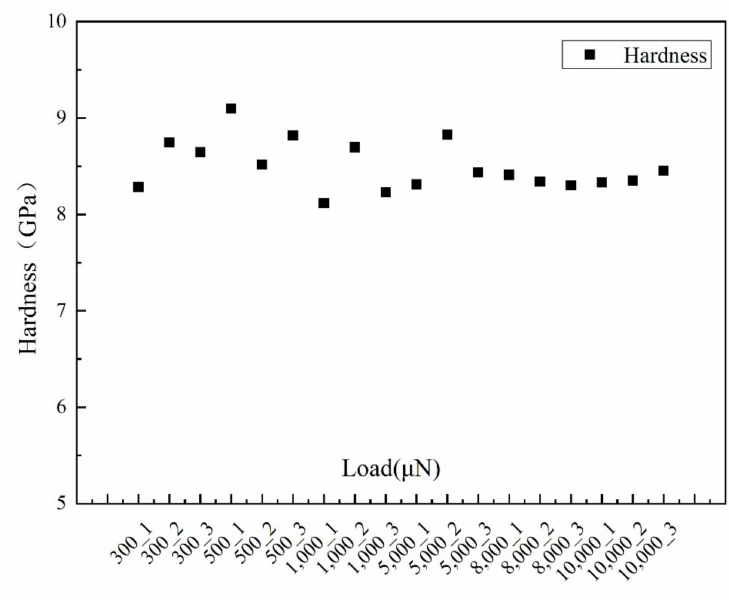
Figure 9. LN hardness under different loads.